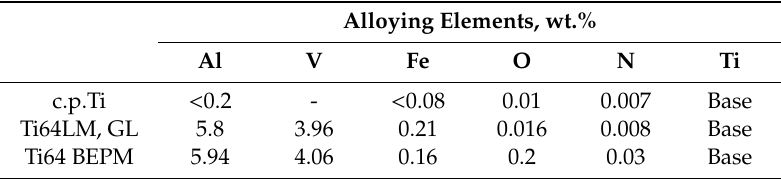
Table 1. Chemical composition of studied materials. Alloying Elements,